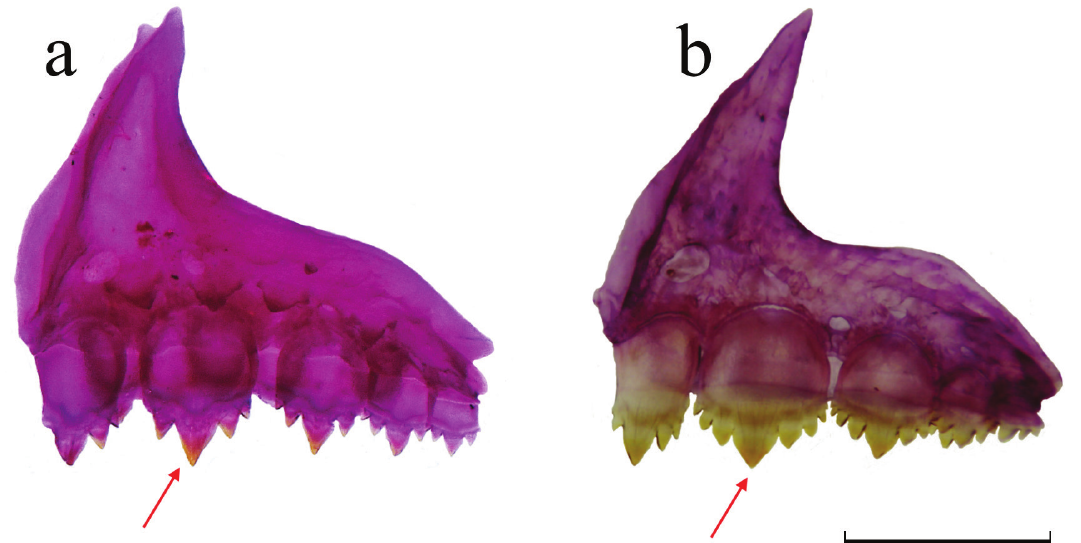
Figure 4. Arrows (red color) indicating the second tooth of the inner row of the premaxilla: a ) Moenkhausia britskii , paratype, MZUSP 17537; b ) Moenkhausia grandisquamis , MZUSP 38244. Medial view. Scale bar = 1